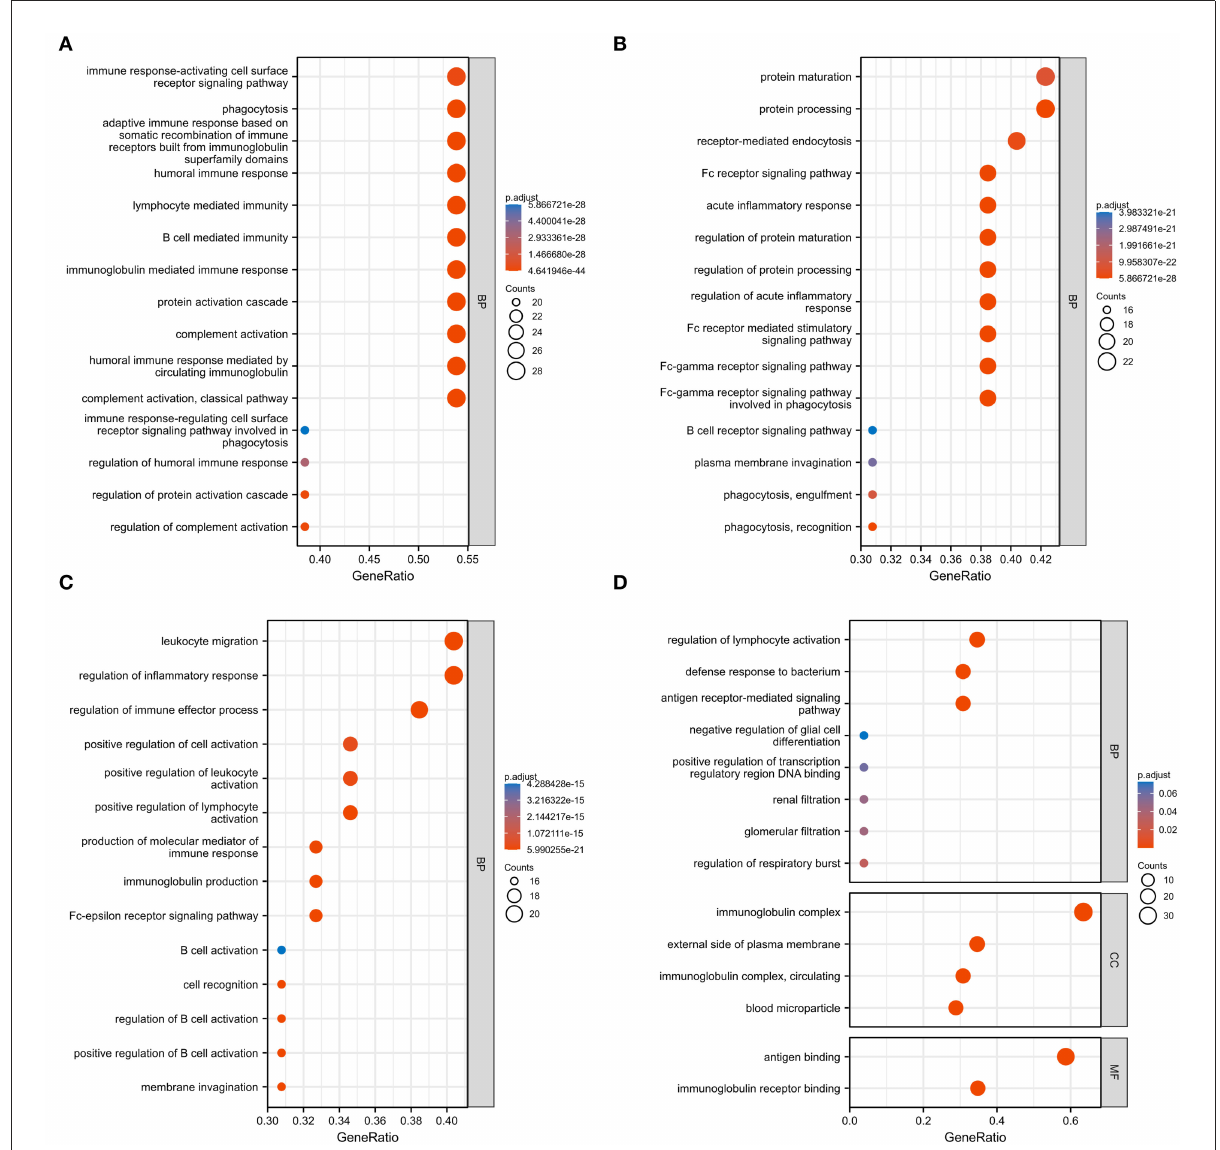
FIGURE3 Gene ontology (GO) analysis of 59 common DEGs. (A–D) Fifty-eight GO terms were enriched. BP, biological process; CC, cellular component; MF, molecular function.